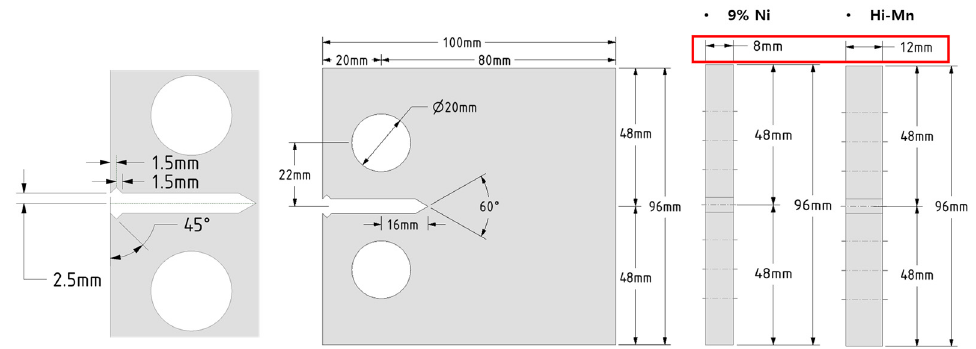
Figure 6. Detailed dimensions of compact tension specimens for the FCGR test.